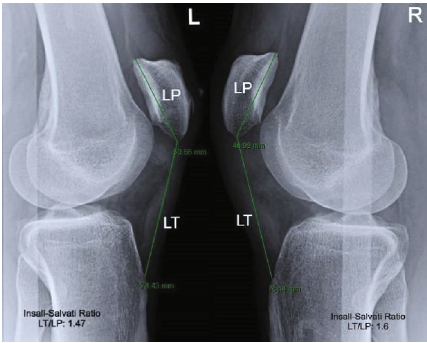
Figure 1: Lateral knee radiographs after bilateral patellar tendon rupture, showing patella alta, knee e ff usions, and irregularity of the patellar tendons. Con fi rmed diagnosis using the Insall-Salvati ratio.